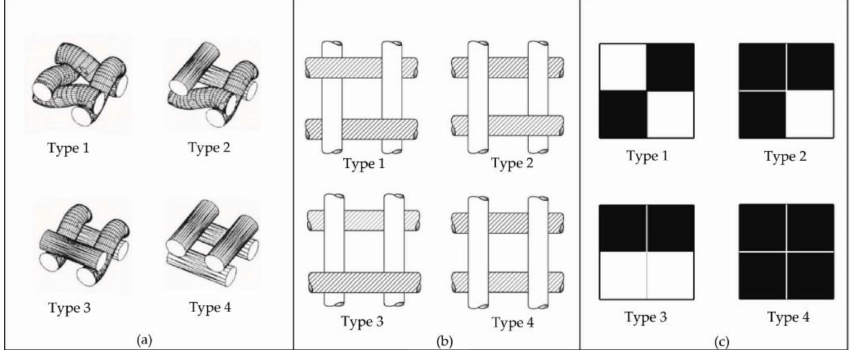
Figure 1. Four types of pores in woven fabrics, shown: three-dimensionally ( a ), planar ( b ), and on woven paper ( c )